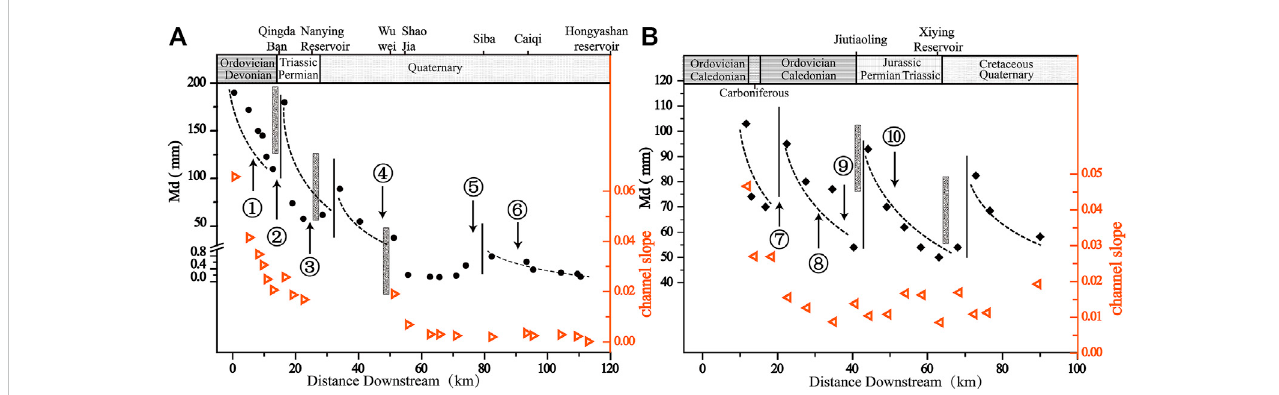
FIGURE 5 The relationshipbetweenslope, tributary in fl ow andMd ofsedimentsinJinta — Shiyanghe River (A,B) Xiying River. ① - ⑩ indicate Xigou, Binggou, Dashui, Yangjiaba, Baita, Hongshui, Qingyang, Tuoluo, Shuiguan, and Xiangshui Rivers, respectively. The gray strips indicate human settlements and